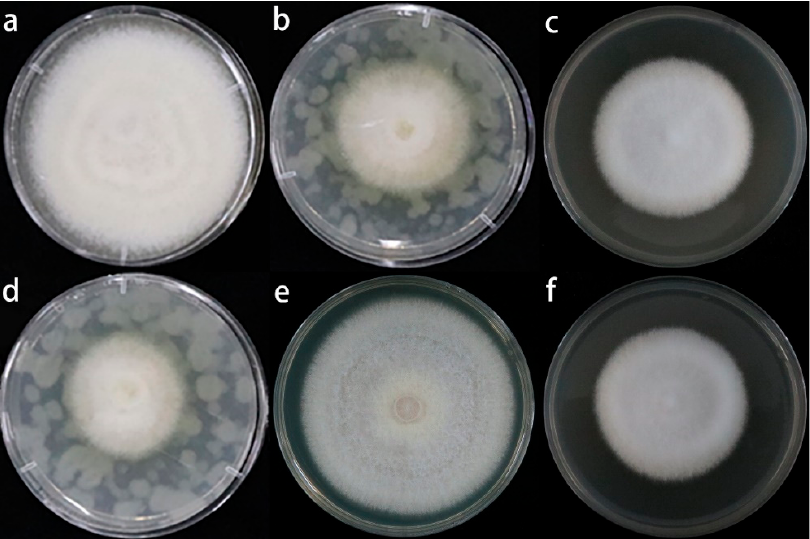
Figure 6. Effect of sulfur compounds and root exudates of A. fistulosum L. on the growth of the Fusarium solani isolate HBH 08. ( a ) UN, untreated replanted soil (control); ( b ) RE, A. fistulosum L. root exudates by hydroponics; ( c ) LCDMDS, measured concentrations of DMDS (22.4 μ g/mL); ( d ) HCDMDS, 5 times the measured concentration of DMDS (112 μ g/mL); ( e ) LCDADS, measured concentrations of DADS (15.2 µ g/mL); ( f ) HCDADS, 5 times the measured concentration of DADS (76 µ